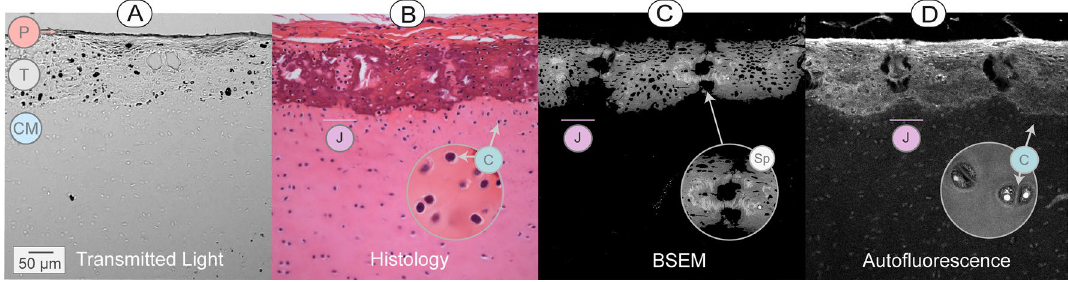
Fig. 3 Comparison of different imaging techniques for tessellated cartilage. A Image of unstained sample acquired using transmitted light (confocal microscope, 10× objective). B LM image of a demineralized sample, stained with Hematoxylin–Eosin. The zoomed circles in B and C show chondrocytes in the cartilaginous matrix. C Backscatter Scanning Electron Microscopy image showing mineral density varia- tion in mineralized regions of the tissue, but no information in non-mineralized areas. The zoomed circle shows a higher magnification of spokes laminae, highly mineralized bands located at the contact region of two tesserae. D AF image, excited with the 405 nm laser (confocal microscope, 10× objective). All images correspond in scale with A. Chondrocytes (C), Cartilaginous matrix (CM), Joint (J), Perichondrium (P), Spokes